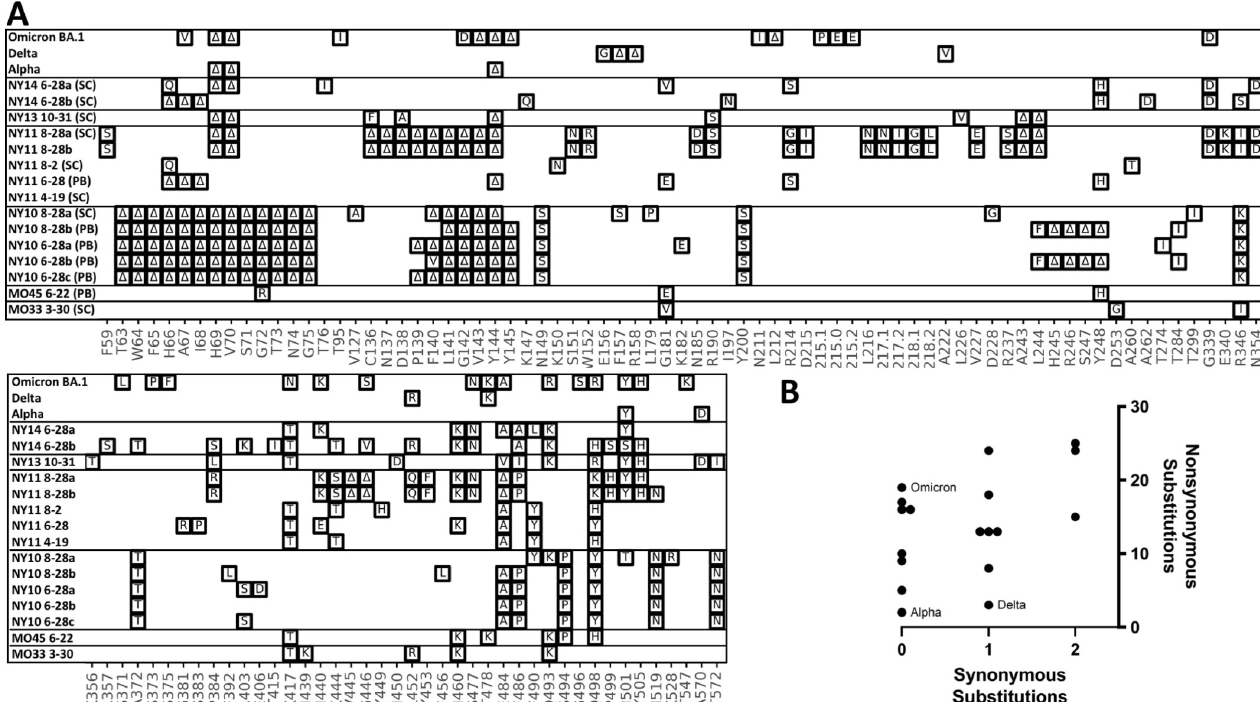
Fig 7. S1 amplifications. A. Overview of the SARS-COV-2 Spike S1 lineages in the Alpha, Delta, Omicron VOCs and six of the sewersheds with cryptic lineages. S1 amplifications were sequenced by subcloning (SC) and Sanger sequencing, or were sequenced using a PacBio (PB) deep sequencing. B. Plot of the number of synonymous and non-synonymous changes in the S1 sequences